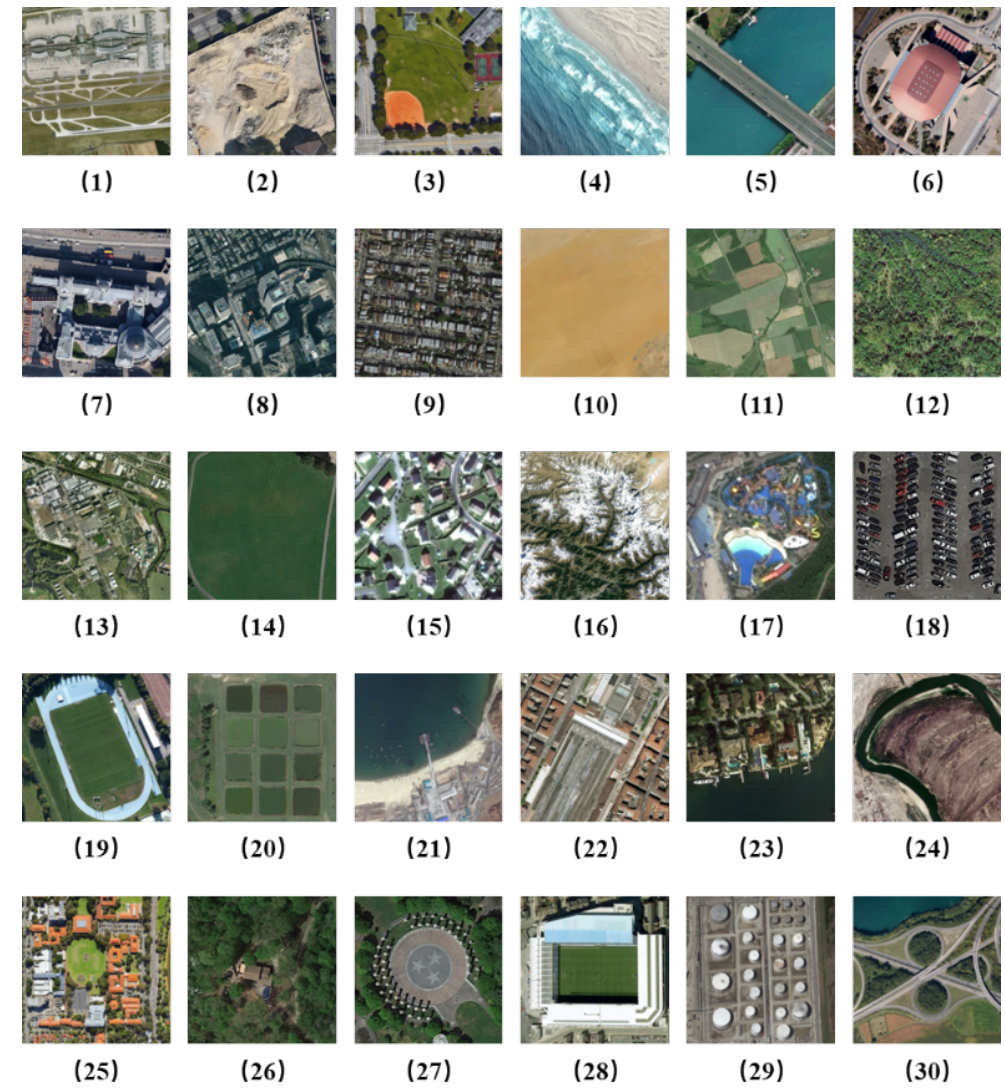
Figure 8. Example images of the AID dataset: ( 1 ) Airport, ( 2 ) Bare Land, ( 3 ) Baseball Field, ( 4 ) Beach, ( 5 ) Bridge, ( 6 ) Center, ( 7 ) Church, ( 8 ) Commercial, ( 9 ) Dense Residential, ( 10 ) Desert, ( 11 ) Farmland, ( 12 ) Forest, ( 13 ) Industrial, ( 14 ) Meadow, ( 15 ) Medium Residential, ( 16 ) Mountain, ( 17 ) Park, ( 18 ) Park- ing, ( 19 ) Playground, ( 20 ) Pond, ( 21 ) Port, ( 22 ) Railway Station, ( 23 ) Resort, ( 24 ) River, ( 25 ) School, ( 26 ) Sparse Residential, ( 27 ) Square, ( 28 ) Stadium, ( 29 ) Storage Tanks, ( 30 )